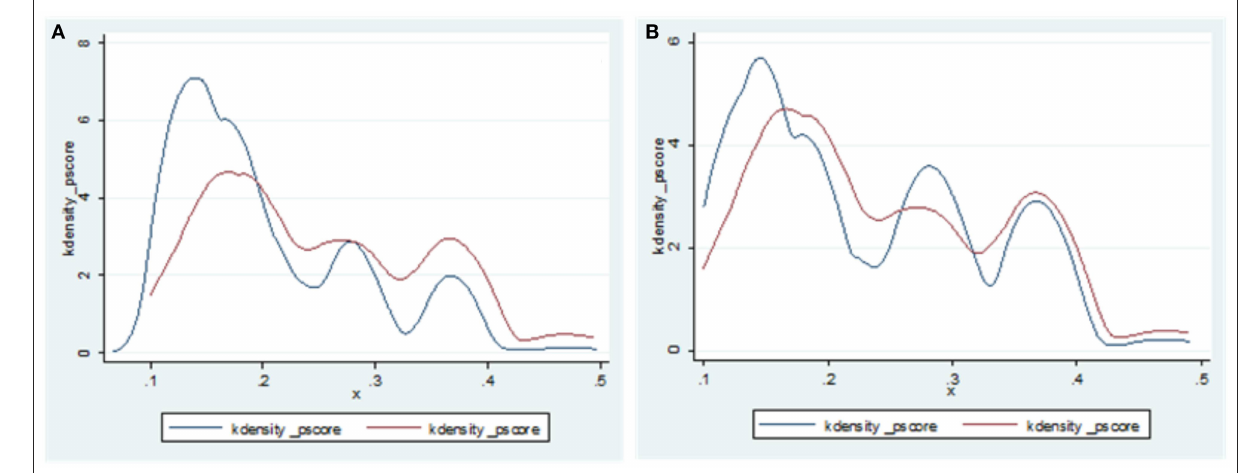
FIGURE3 Balance test before (A) and after (B) matching between treatment group and control group.